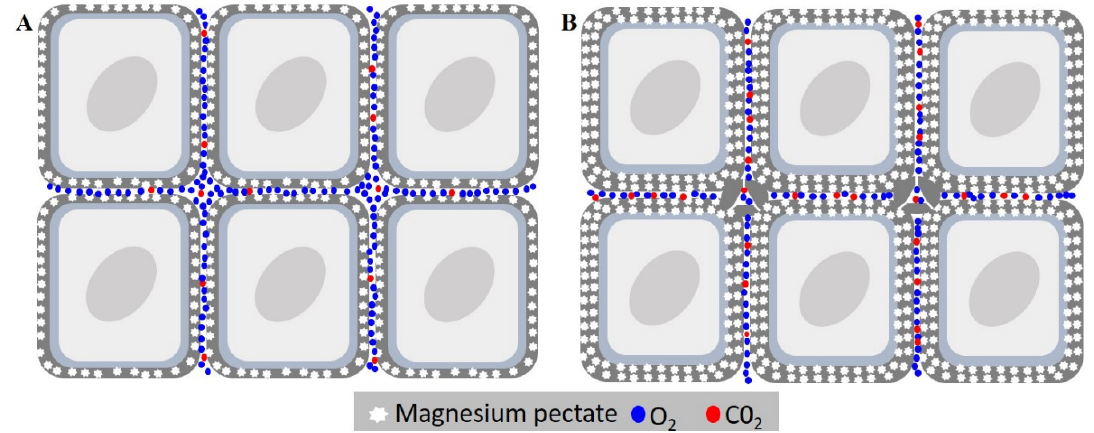
Figure 10. Effects of magnesium concentration in seed deterioration. ( A ) Cell of embryonic axis tissue with low magnesium content. ( B ) Cell of embryonic axis tissue with higher magnesium content. The high magnesium content causes thickening of medium lamella by the increasing of magnesium pectates, reducing gas diffusion of the internal tissue. This leads to the accumulation of CO 2 in the tissue, reducing respiration, and leading consequently to a reduction in seed deterioration.